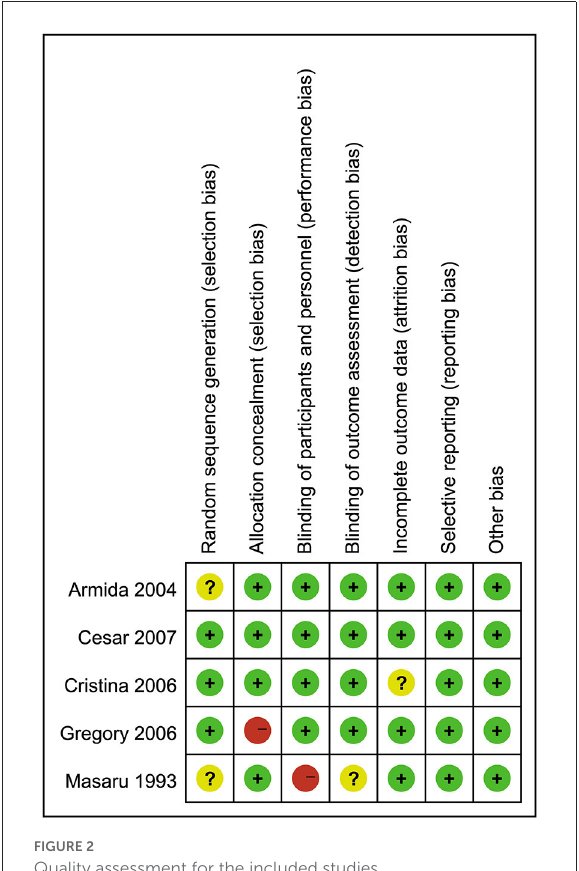
FIGURE2 Quality assessment for the included